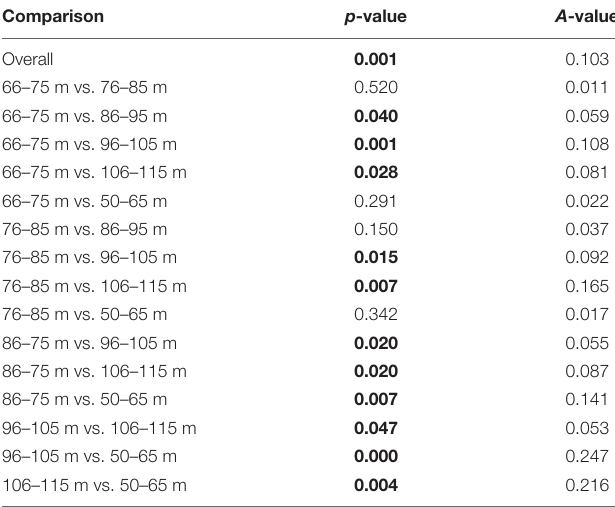
TABLE 5 | MRPP results of depth categories